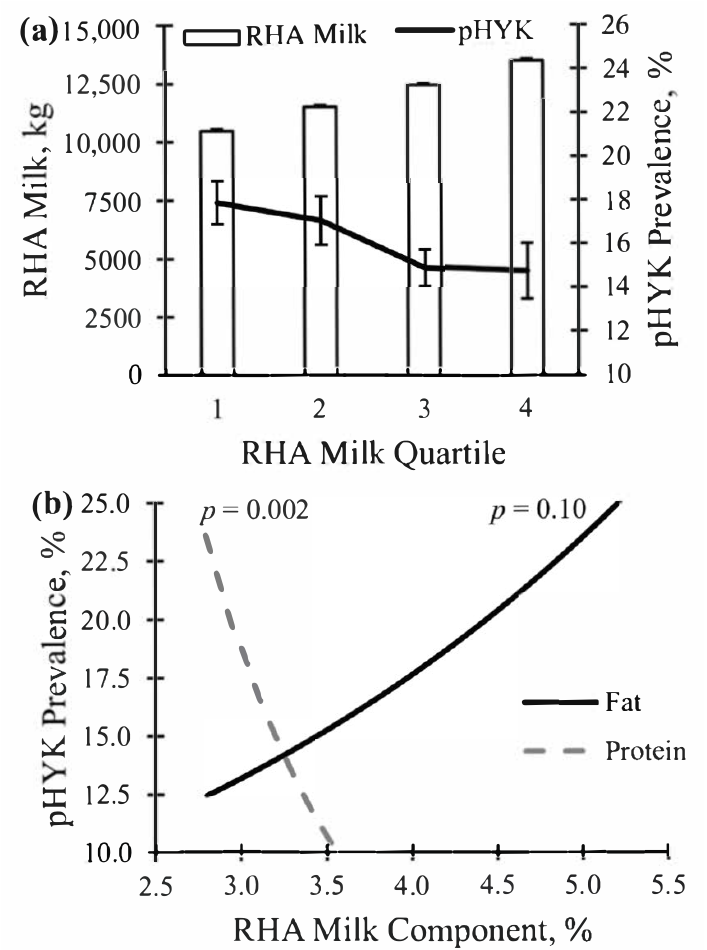
Figure 1. Prevalence of predicted hyperketonemia (HYK) status ( a ) across rolling herd average (RHA) milk production quartiles and ( b ) as associated with RHA milk fat and protein percent in a test day dataset of herds from the Midwest region of the United States. Prevalence of HYK was based on proportion of samples collected between 5 and 20 days in milk predicted as HYK (pHYK; predicted BHB ≥ 1.2 mM) or not (pNonHYK; predicted BHB < 1.2 mM). Herds and records per quartile: Q1: 158 and 2885; Q2: 147 and 2884; Q3: 142 and 2885; Q4: 100 and 2885. Panel ( a ): modeled linear effect of pHYK prevalence using generalized estimating equation weighted based on the number of cows ( p = 0.02). Panel ( b ): HYK predicted prevalence was negatively associated with RHA protein % ( p = 0.002) but there was no evidence of association for RHA fat % ( p = 0.10). Birth rate of twins did not differ ( p = 0.34) by predicted HYK status (4.1% ± 0.2 vs. 3.9% ± 0.1 pHYK vs. pNonHYK). Calving interval was greater ( p < 0.001) for pHYK than pNonHYK (418 ± 1 vs. 401 ± 1 days). Calving ease score was greater ( p < 0.001) for pHYK cows and was affected by parity ( p < 0.001). The interaction of predicted HYK status and parity affected ( p = 0.002) calf mortality (Figure 3) and was greater for pHYK, compared to pNonHYK, first lactation